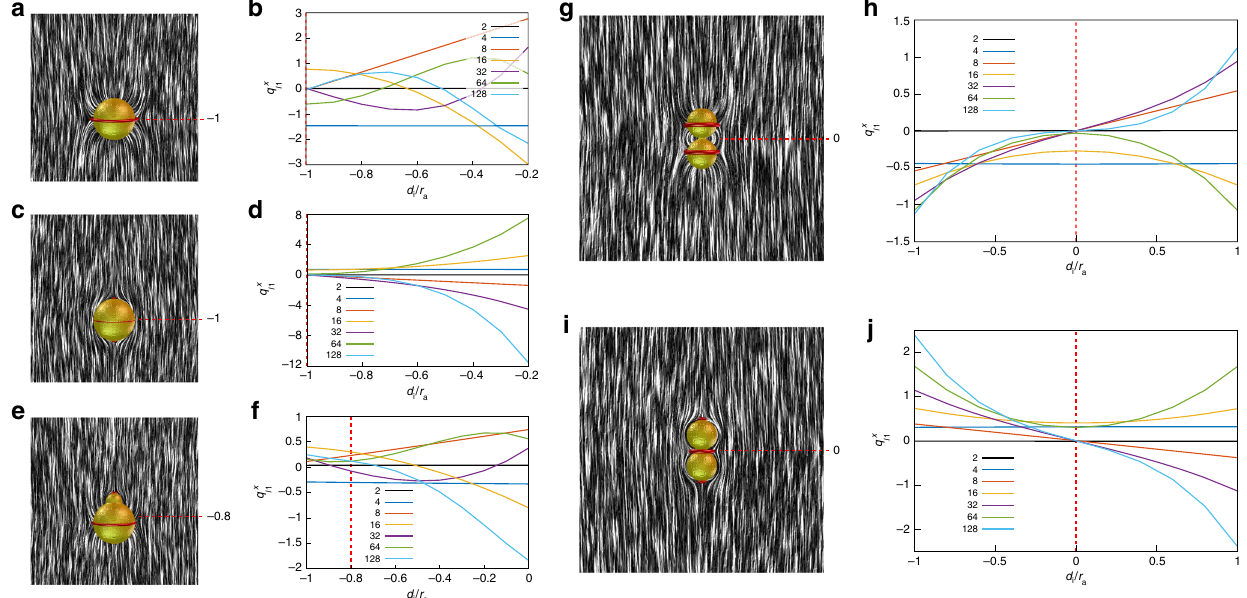
was calculated for selected simulated composite nematic Fig. 9 Examples of spherical multipole moments of composite nematic colloids. The value of q x l 1 colloids and chain particle comprising of two equal spheres. a Colloidal particle with homeotropic boundary conditions centered at r a below the origin induces a quadrupolar distortion of n ( r ), commonly known as a Saturn ring con fi guration. b Corresponding graph shows constant quadrupole coef fi cient at all displacements d i , other multipoles have extreme or zero at d i = − r a , corresponding to the geometrical center of the spherical colloid. c Spherical colloidal particle with conic anchoring at angle α = 20° centered at r a below the origin. d Plot shows that quadrupolar coef fi cient is constant at all d i , whereas other coef fi cients higher then 16-pole are zero when center of the interpolation sphere coincides with geometrical center d i = d a . e Composite colloidal particle at r a below the origin with d b = 0, r b = 2 r a /5 and conic anchoring at angle α = 60°. f Quadrupolar coef fi cient is constant regardless the position of the interaction sphere, whereas higher multipole moments show complex variations even at the geometrical center. Geometrical centers of the composite colloids are depicted with red dashed line. g Chain colloid with homeotropic anchoring on the surfaces induces two Saturn rings. h The director fi eld shows strong quadrupolar and hexadecapolar, and weak 64-polar contribution. Higher multipoles are zero in the geometrical center of a composite chain colloid. i Chain colloid with tangential anchoring induces strong neck defect and two boojums at the poles. j The director fi eld shows strong hexadecapole, quadrupole and 64-pole, whereas higher multipoles are zero in the geometrical center. The location of the geometrical center of the colloid is depicted with red dashed line (at d i = (points) gives more balanced representation of a waist region of the sphere in comparison to the poles as if using, e.g., regular grids. The director fi eld n μ used for determining spherical multipole coef fi cients is obtained from numerical calculations based on free energy minimization and is calculated on discrete points of a cubic mesh, which do not match with points on the sphere. Therefore, we perform trilinear interpolation of the tensor order parameter Q ij , to get Q ij at arbitrary point in space